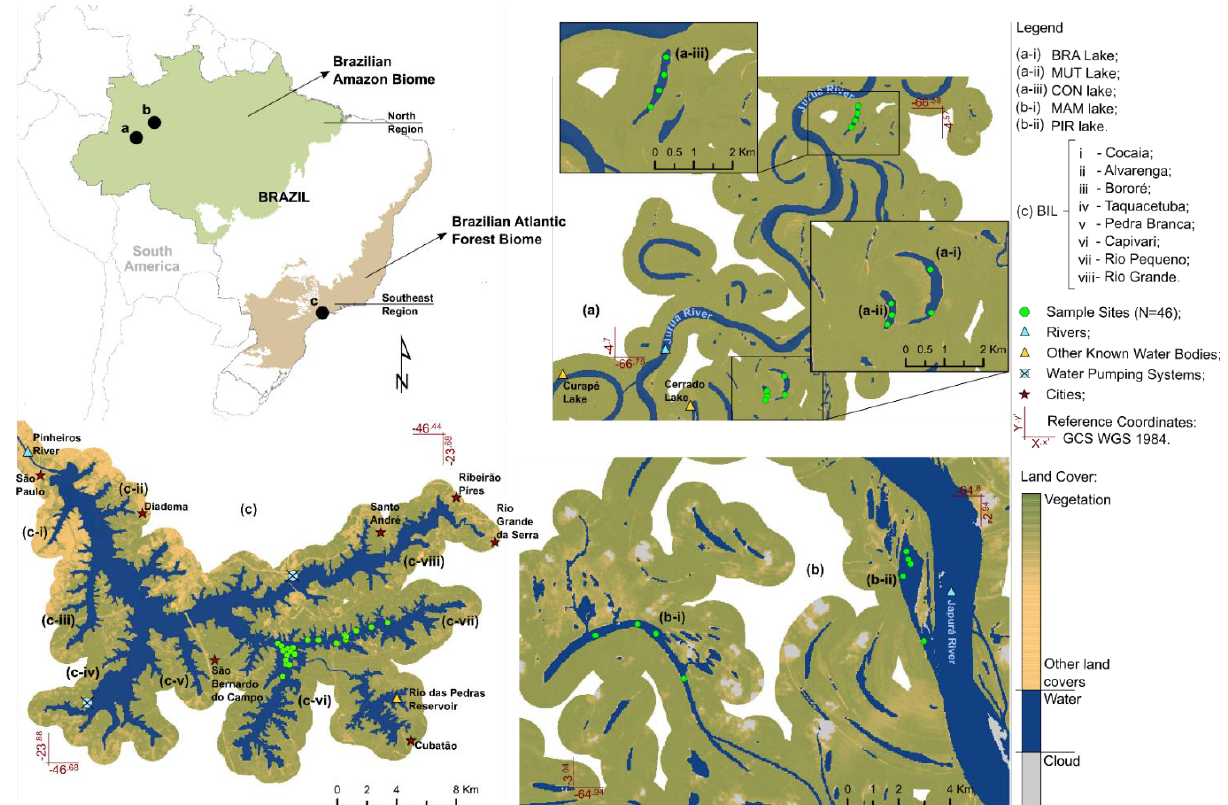
Figure 1. Overview of the study area: ( a , b ) Amazon floodplain lakes and ( c ) urban reservoir. The sampling points are illustrated by green dots. The green – pale orange gradient represents the land cover (e.g., vegetation and other land covers), and the blue and gray colors refer to water and clouds, respectively.